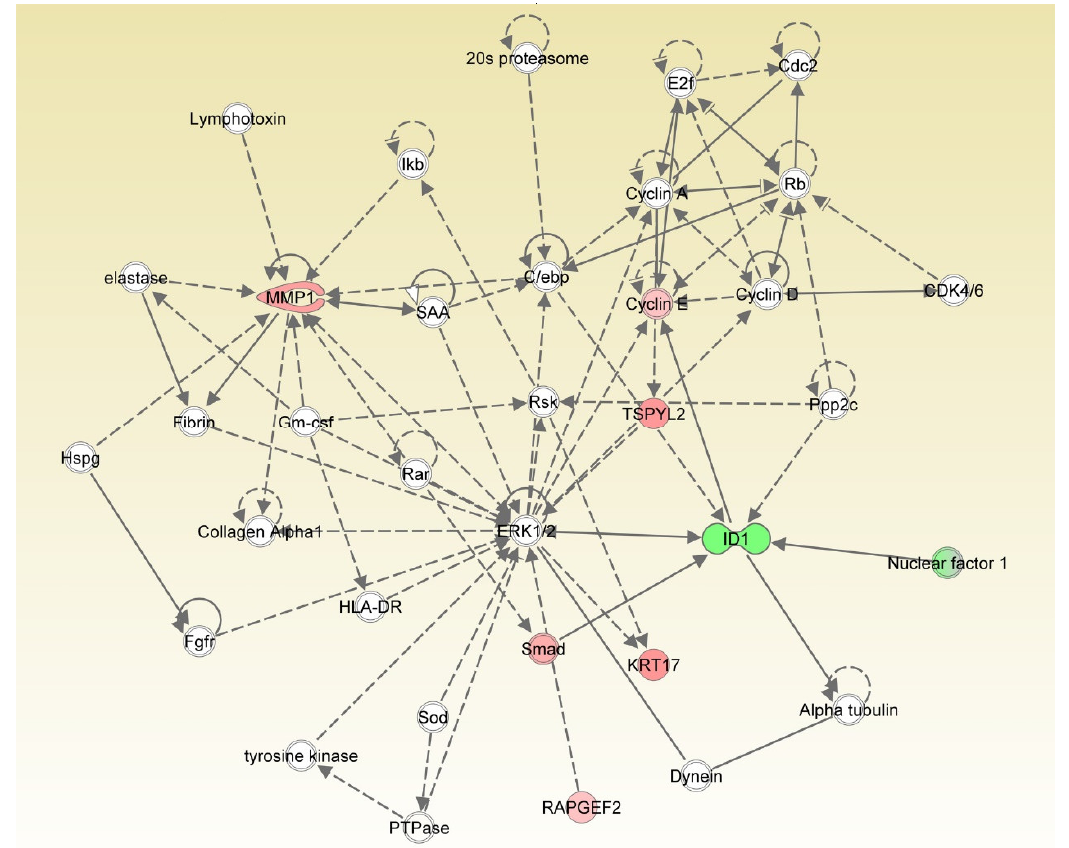
Figure 6. Network analysis of differentially expressed genes . Central gene identification according to IPA core analysis. ERK is the central gene in the interaction network.